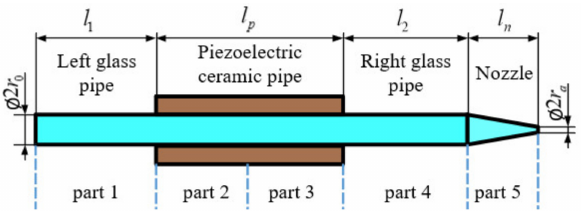
Figure 3. The division of the inkjet printhead and structure